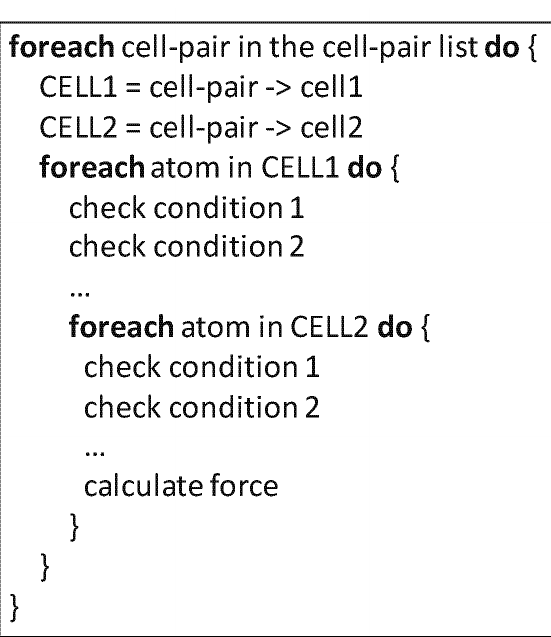
Fig. 5. Algorithm of the non-bonded force computation method using cell-pair